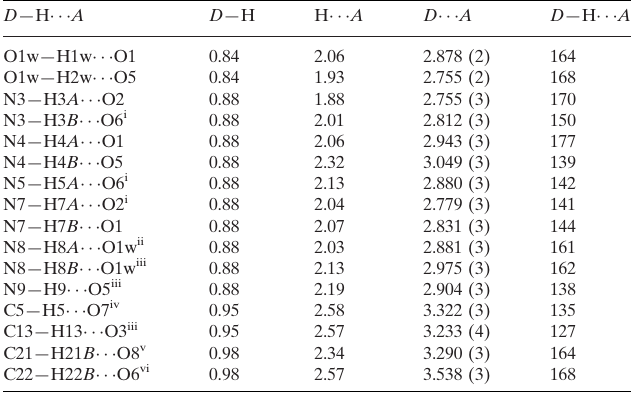
Hydrogen-bond geometry (A˚ , (cid:4)